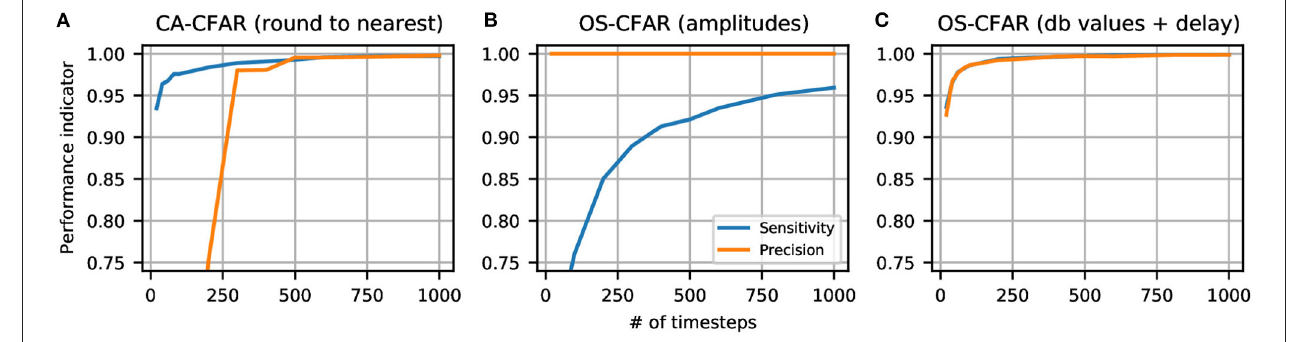
FIGURE 7 | Evaluation of spiking CFAR regarding number of SNN time steps. (A) Spiking CA-CFAR with nearest rounding to discrete time steps. (B) Spiking OS-CFAR with range-Doppler map amplitudes as input. (C) Spiking OS-CFAR with dB values as input and a delay added to time steps of training cells. The evaluation was performed on 1000 range-Doppler maps from the CARRADA dataset.